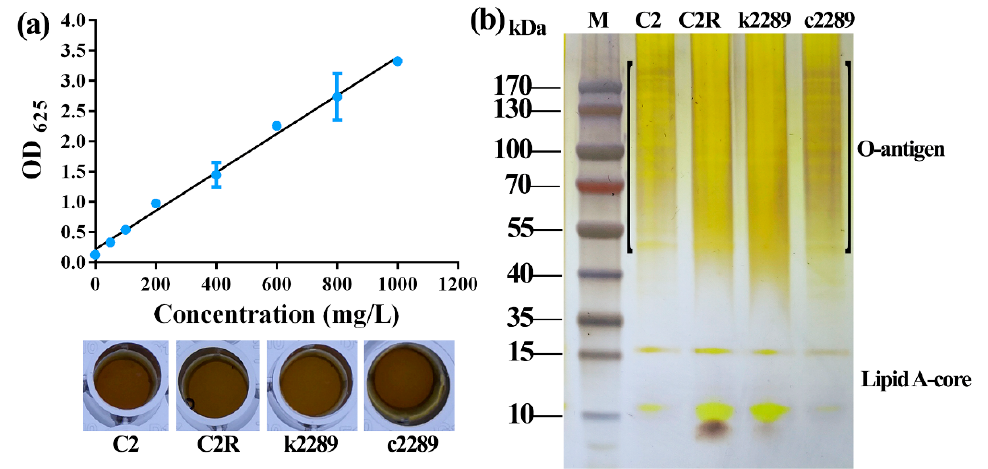
Figure 7. Mutation of glycosyltransferase gene inhibits phage infection by changing LPS structure of Xoo. ( a ) LPS concentration extracting from the bacterial culture at OD 600 = 0.8 was determined based on the standard curve of saccharide established using glucose and the anthrone-sulfuric acid method. ( b ) LPS profiles of C2, C2R, k2289 and c2289 displayed by SDS-PAGE and silver staining.